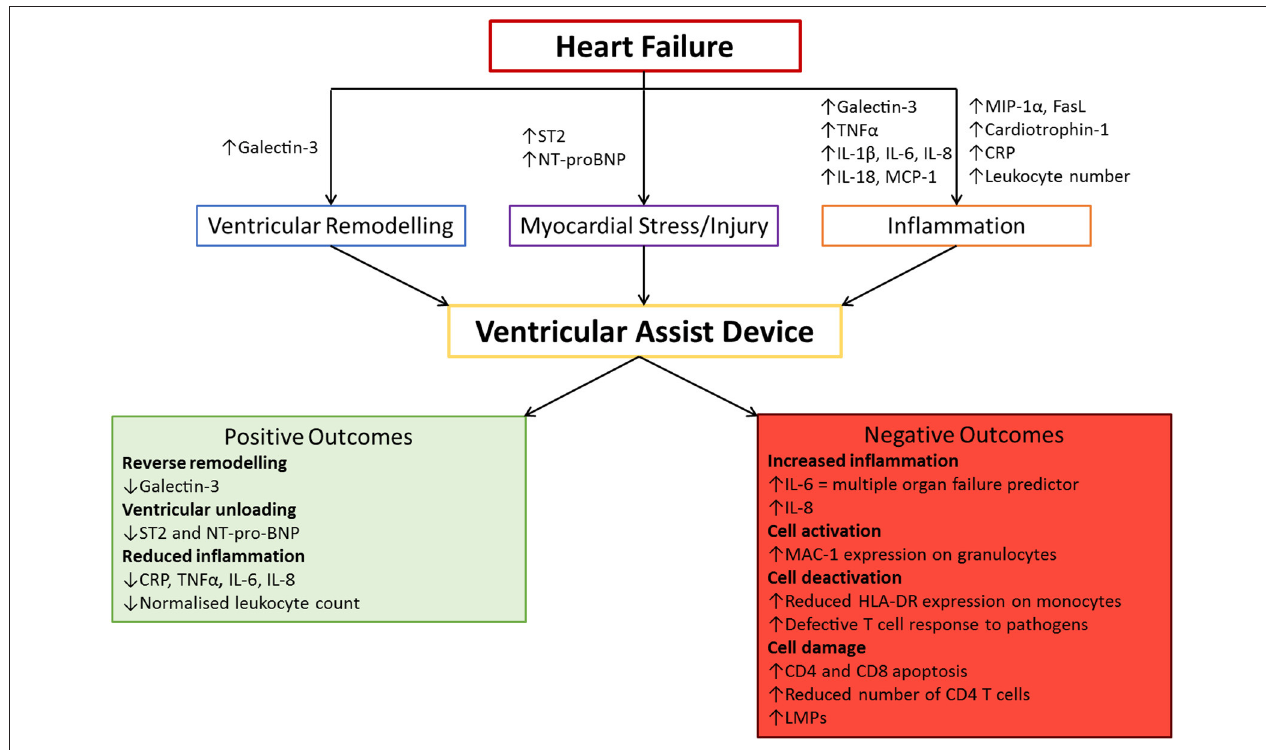
FIGURE 2 | The association between VAD implantation and inflammation. Heart failure has its own distinct inflammatory profile. Ventricular assist device (VAD) implantation can have both positive and negative outcomes which impact the efficacy of using this treatment. These markers can be used to monitor the progression of VAD therapy and predict adverse events for early intervention purposes. CRP, C-reactive protein; IL, Interleukin; MCP-1, Monocyte Chemoattractant Protein 1; MIP-1 α , Macrophage Inflammatory Protein 1 alpha; NT-proBNP, N-Terminal pro Brain Natriuretic Peptide; TNF α , Tumor Necrosis Factor